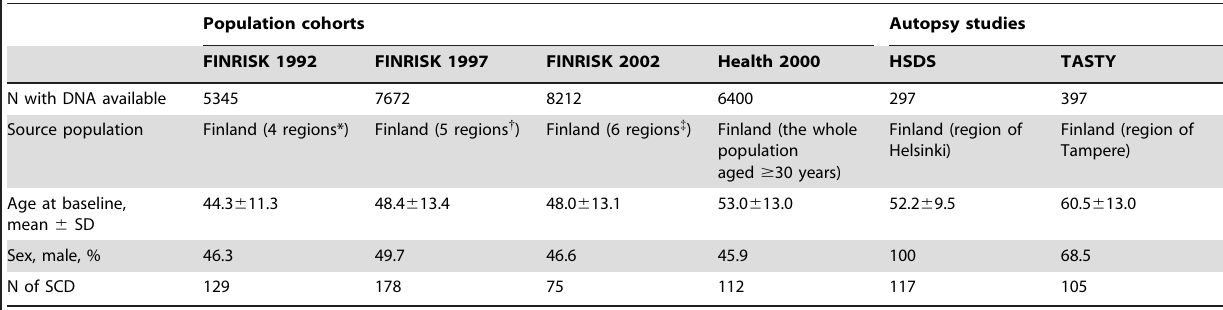
Table 1. Clinical characteristics of the study